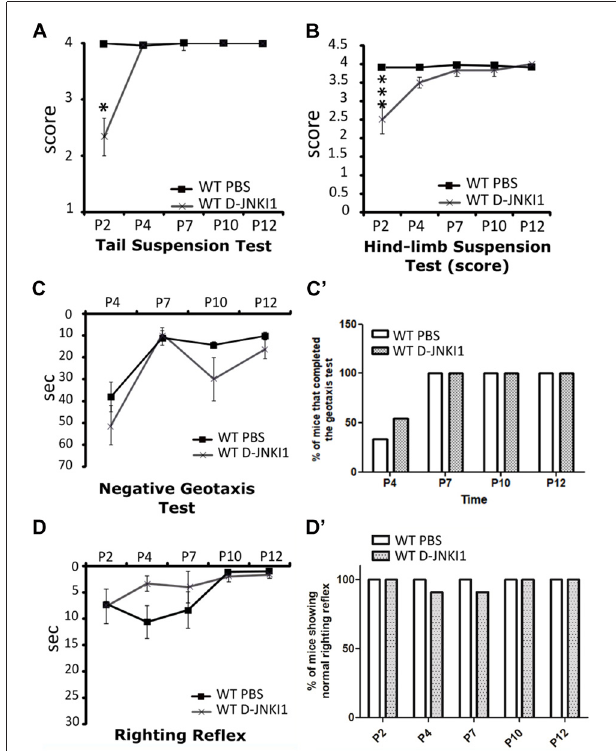
FIGURE 3 | D-JNKI1 treatment partially influences motor performances only in the early phases of development of WT pups. Tail suspension test (A) , hind-limb suspension test (B) , negative geotaxis test (C,C’) and righting reflex test (D,D’) have been used to evaluate the motor performances of PBS- and D-JNKI1-treated WT mice. ∗ P < 0.05; ∗∗∗ P <